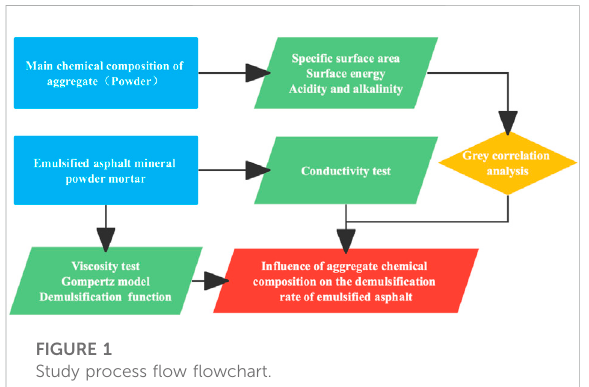
FIGURE 1 Study process fl ow fl owchart.